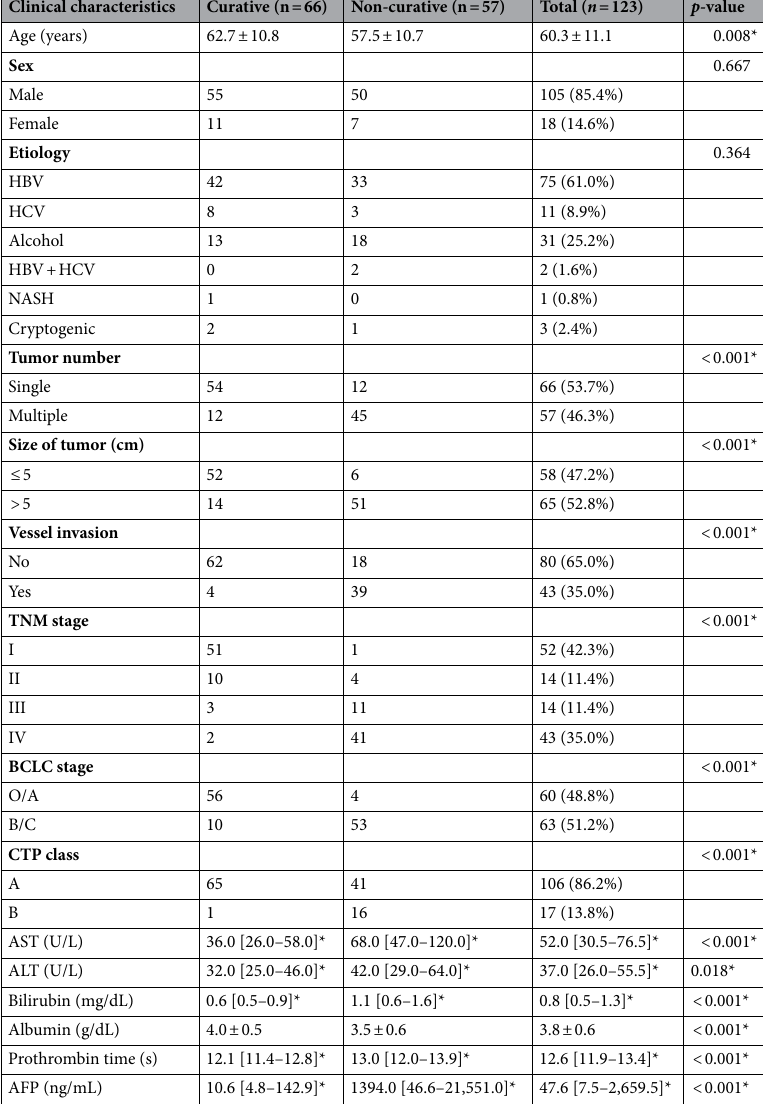
Table 1. Baseline characteristics of patients with HCC. HBV hepatitis B virus; HCV hepatitis C virus; NASH nonalcoholic steatohepatitis; TNM tumor node metastasis; BCLC Barcelona Clinic Liver Cancer; CTP Child– Turcotte–Pugh; AST aspartate transaminase; ALT alanine transaminase; AFP alpha-fetoprotein; *median [25%–75% interquartile